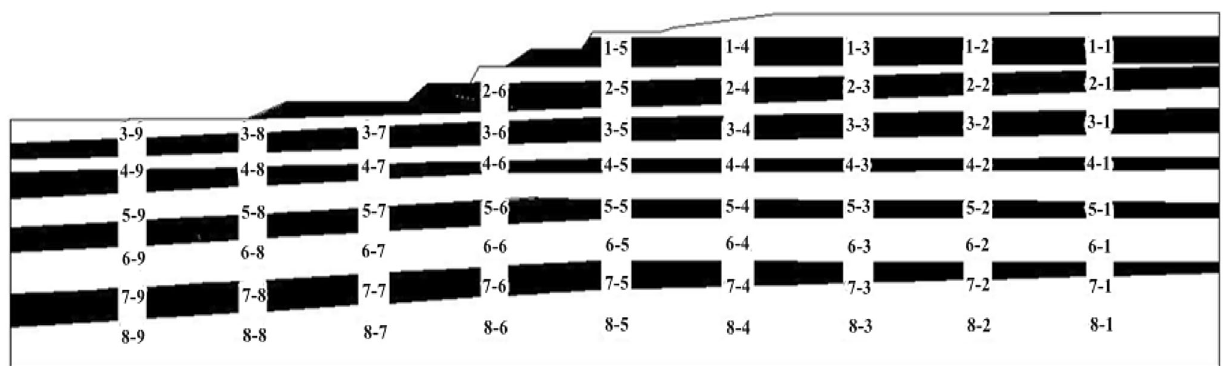
Fig. 8 Layout of the slope displacement monitoring points